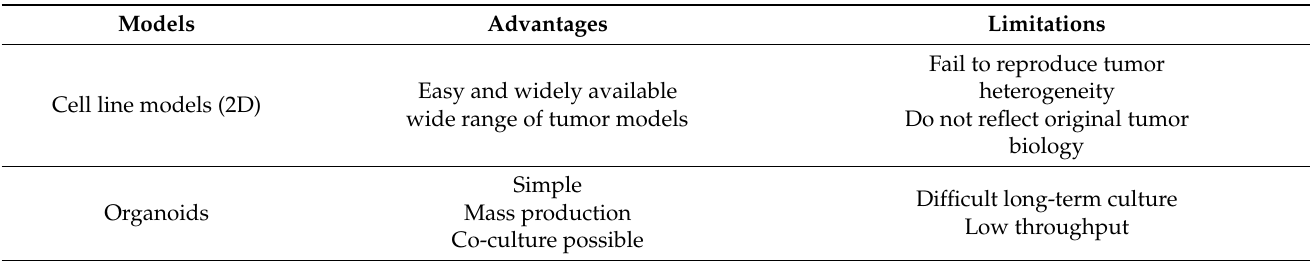
Table 2. Summary of advantages and limitations of the main preclinical models used in cancer